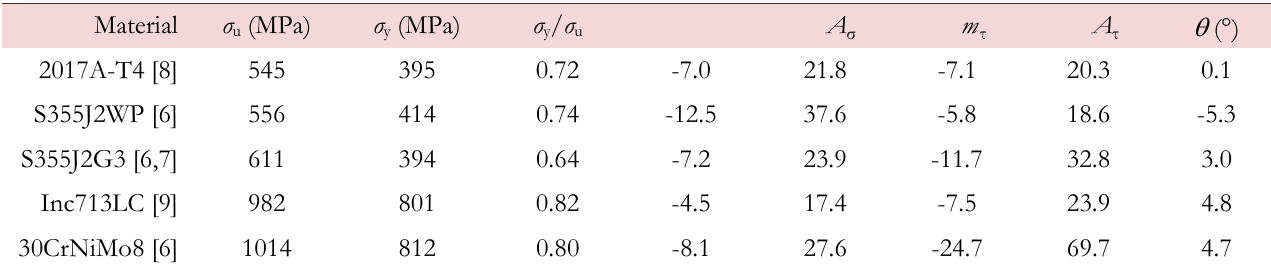
Table 1: Basic material properties and the parameters related to the bending and torsion S-N